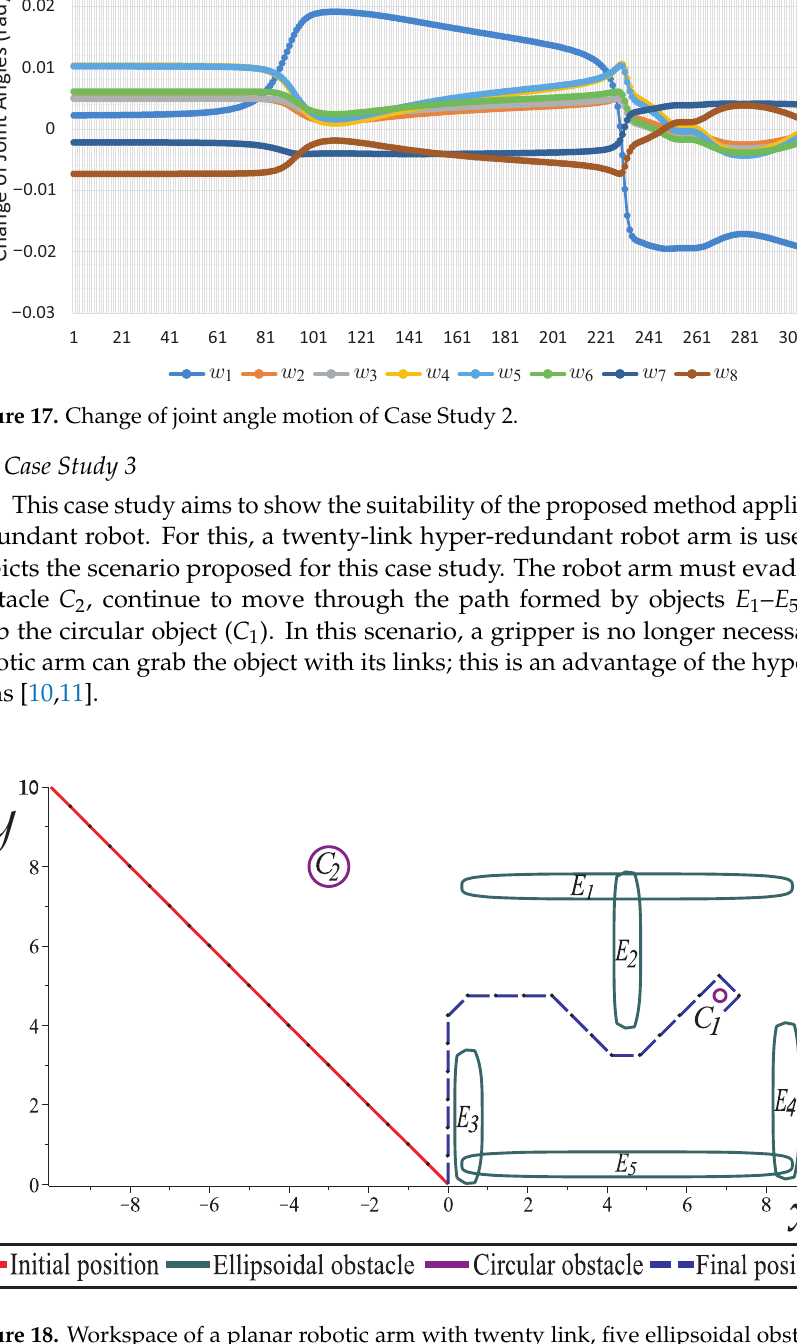
Figure 18. Workspace of a planar robotic arm with twenty link, five ellipsoidal obstacles, and one circular